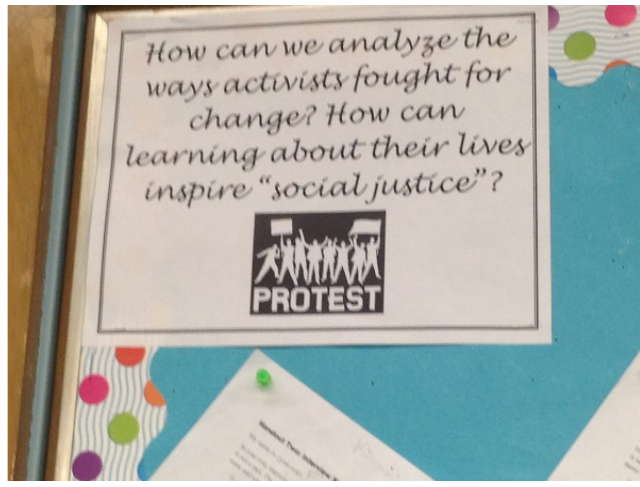
FIGURE 1. THIS SIGN DISPLAYED GUIDING QUESTIONS FOR THE CURRICULUM UNIT ON THE STUDY OF ACTIVISTS AND SOCIAL MOVEMENTS TOWARD SOCIAL